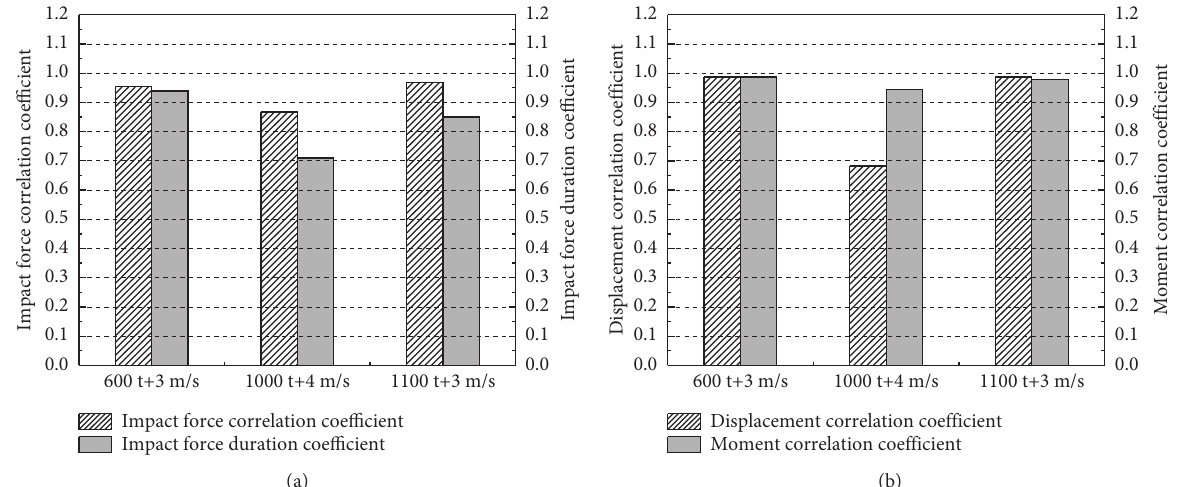
Figure 20: Correlation coefficient of simulation results. (a) Impact force c.c. R2 and impact force duration coefficient ET. (b) Correlation coefficients of displacement of pier top and moment of pier